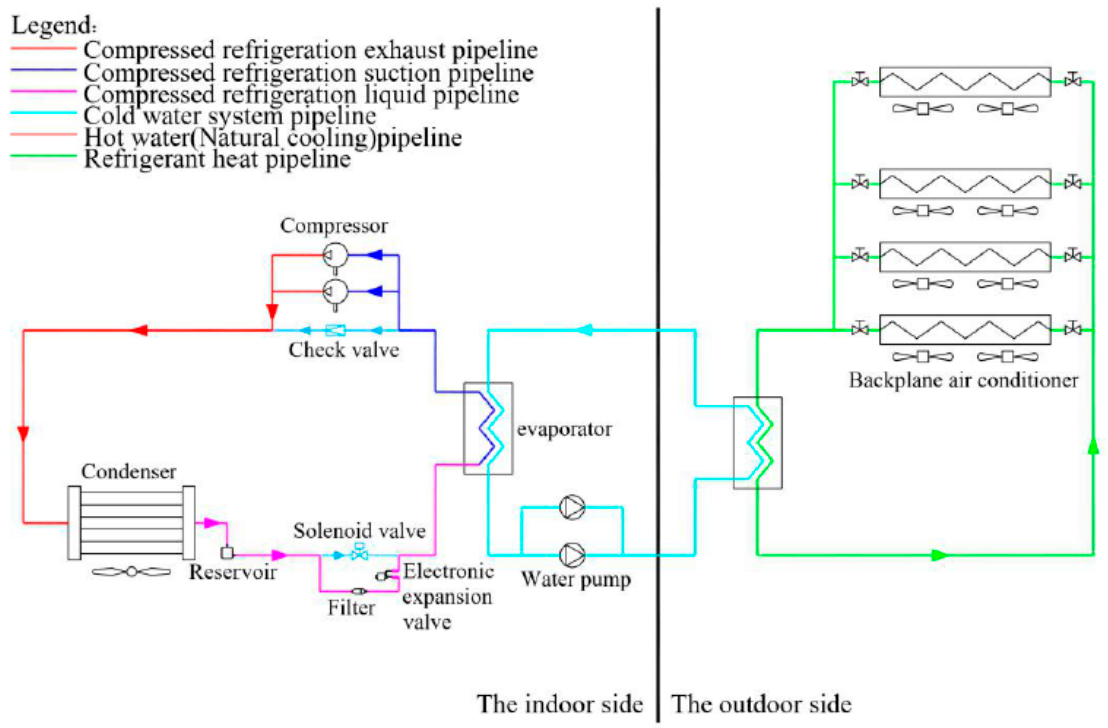
Figure 1. Backplane heat pipe air conditioning system.